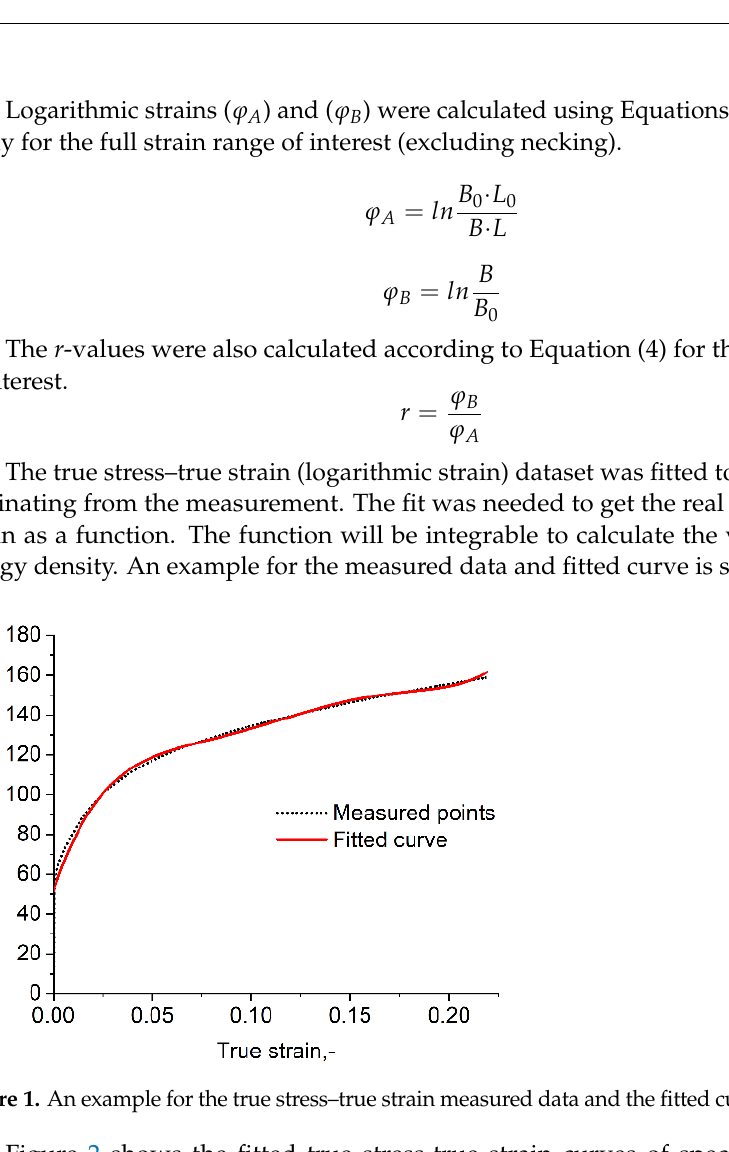
Figure 3. The variation of r -values versus strain energy density for the uniform elongation regime of tensile test specimens cut in different directions. For each sample direction, r -values were determined for a constant strain energy den- sity value (namely at 25 J/cm 3 , being the last common point before necking) for all 5 direc- tions instead of constant axial (logarithmic) strains. This method was chosen to avoid the disturbing effect originating from that textured tensile test specimens show different formability in different directions. The r -values of the parallel test specimens were aver- aged. The earing profile was obtained from the averaged r -values according to Yoon’s formula (Equation (5)) which is described in reference [19] in detail. ℎ 𝜑 = 𝑟 𝑝 + (𝑅 b + 𝑅 c ) +